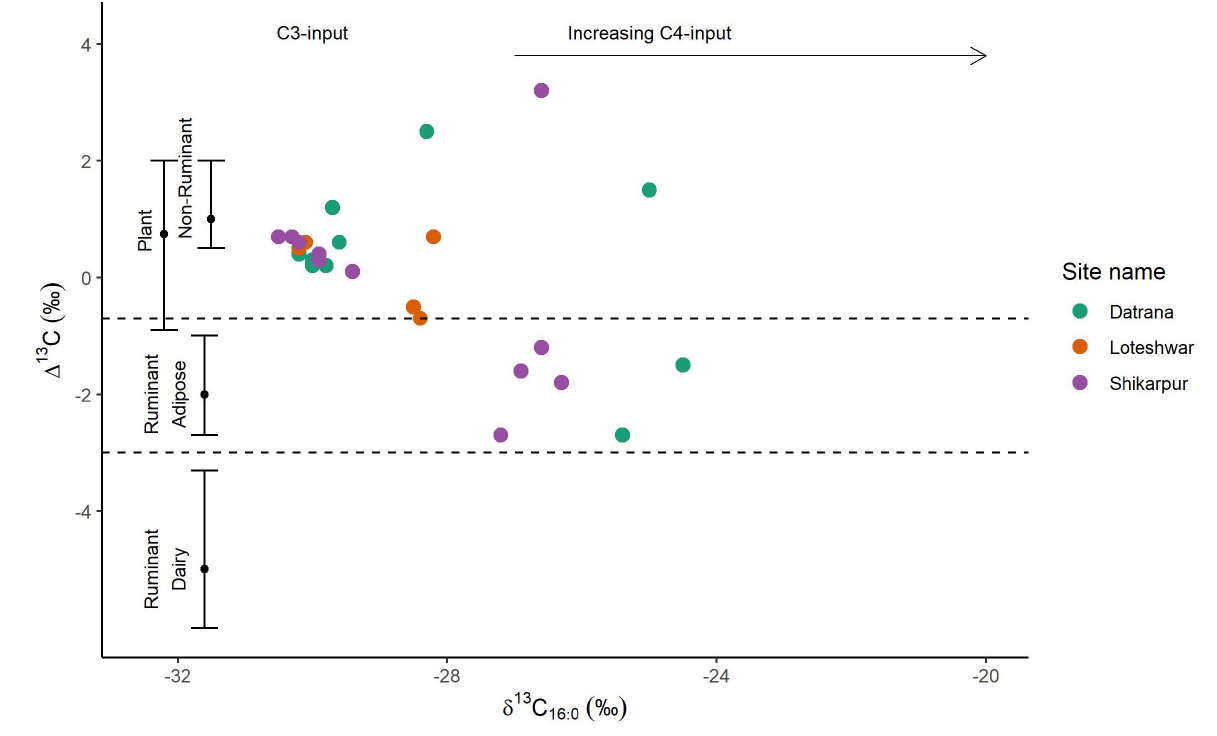
FIGURE 2 | Compound-specific isotopic values by site. The difference in δ 13 C -values for C 16 : 0 and C 18 : 0 fatty acids ( (cid:49) 13 C) are plotted against δ 13 C -values for C 16 : 0 fatty acids against a global reference range for modern porcine, ruminant carcass, dairy fats and plant oils (Copley et al., 2003; Spangenberg et al., 2006; Gregg et al., 2009; Outram et al., 2009; Steele et al., 2010; Dunne et al., 2012; Hendy et al.,